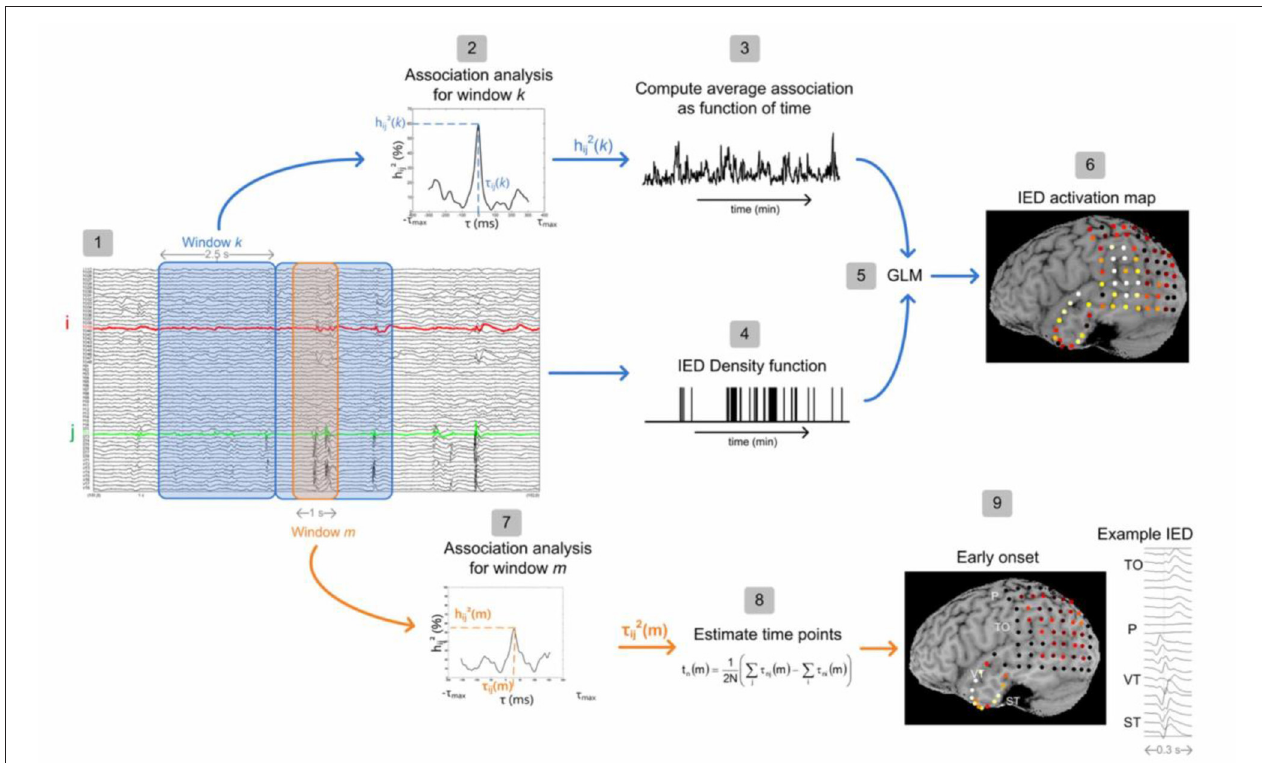
FIGURE 17 | Flowchart of ECoG analysis consisting of two steps: estimation of interictally active ECoG areas (steps 1–6) and the estimation of an onset area (steps 7–9) (